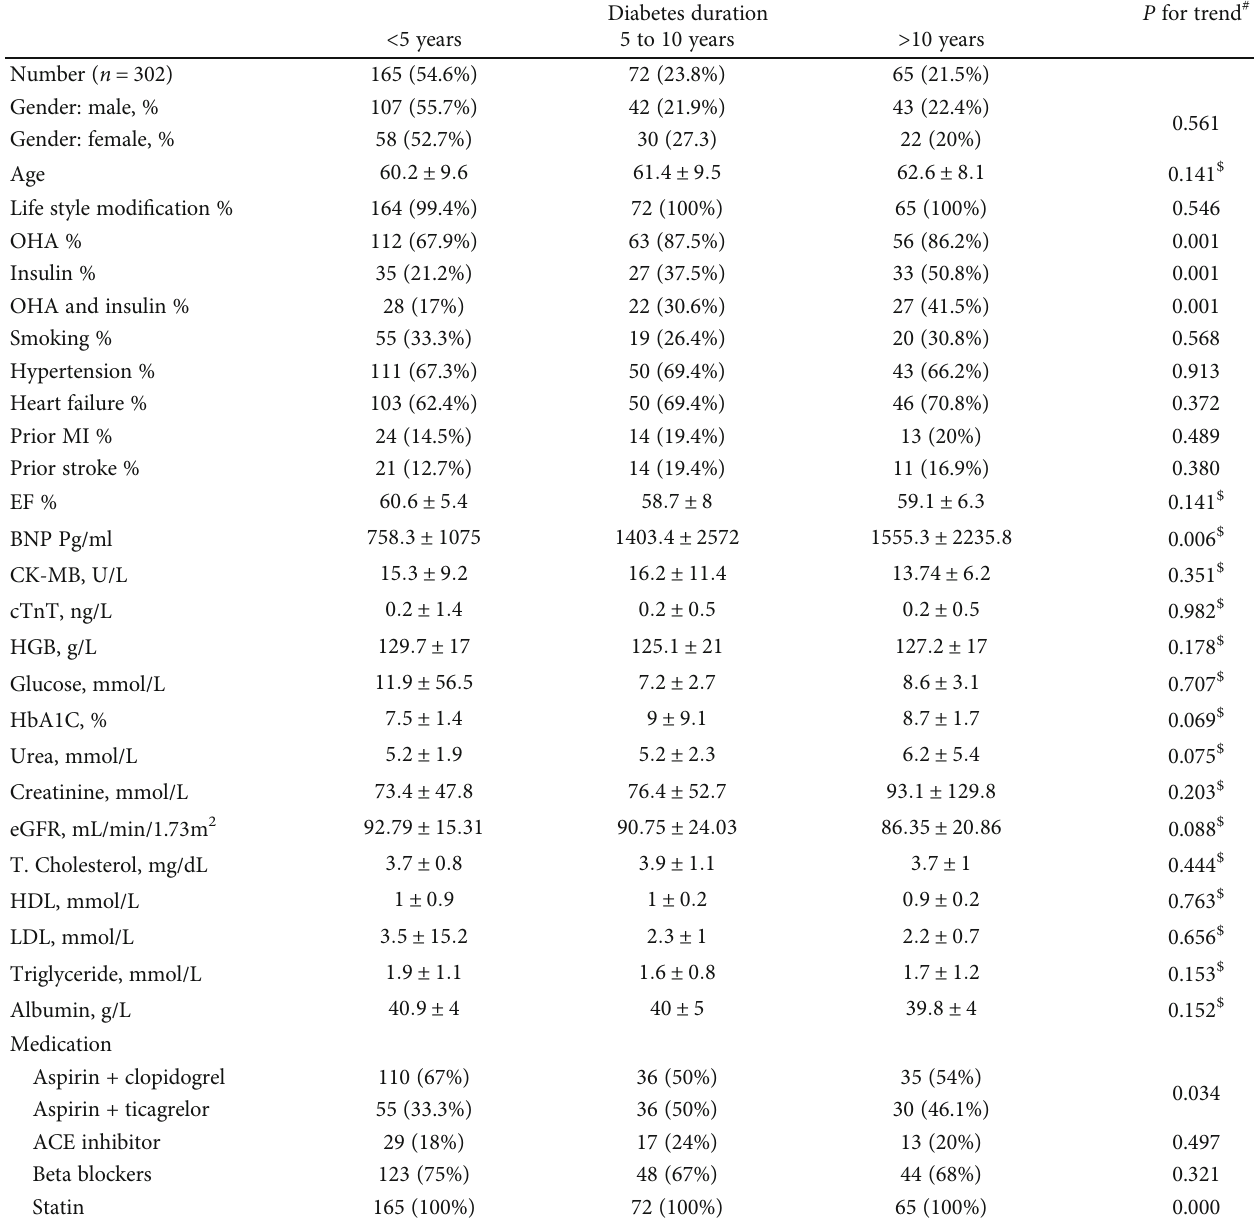
Table 1: Demographic and baseline